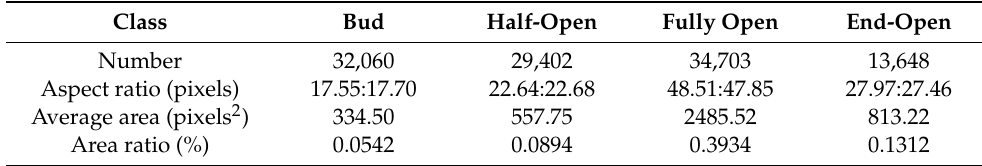
Table 4. Annotated data information after slicing using the SAHI